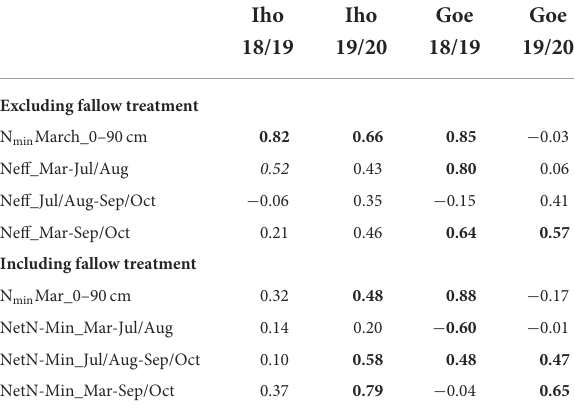
TABLE 5 Pearson correlation coefficients for the correlation among sugar yield and soil mineral N content (N min ) in March, net N-mineralization (NetN-Min) under following unfertilized sugar beet, and the cover crop N effect on sugar beet (N eff ) for different periods at Ihinger Hof (Iho) and Göttingen (Goe), both in 2018/19 and